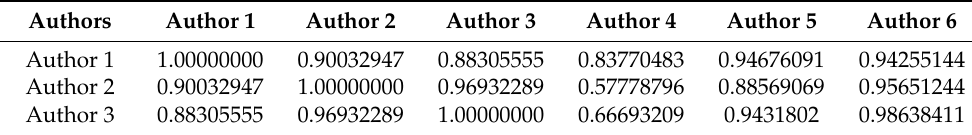
Table 6. Authors’ similarity matrix based on the statistics of their publication